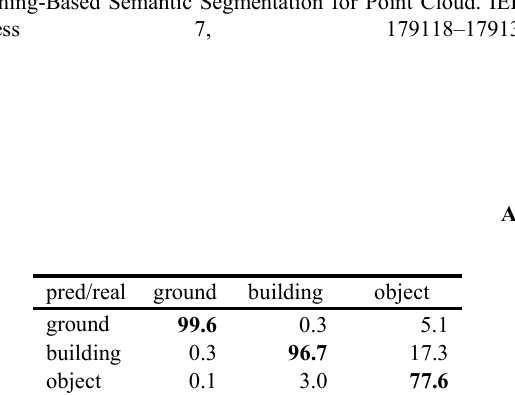
Table 2: Confusion matrix (% recall ) for 3 classes, 200 hidden layers and unweighted.